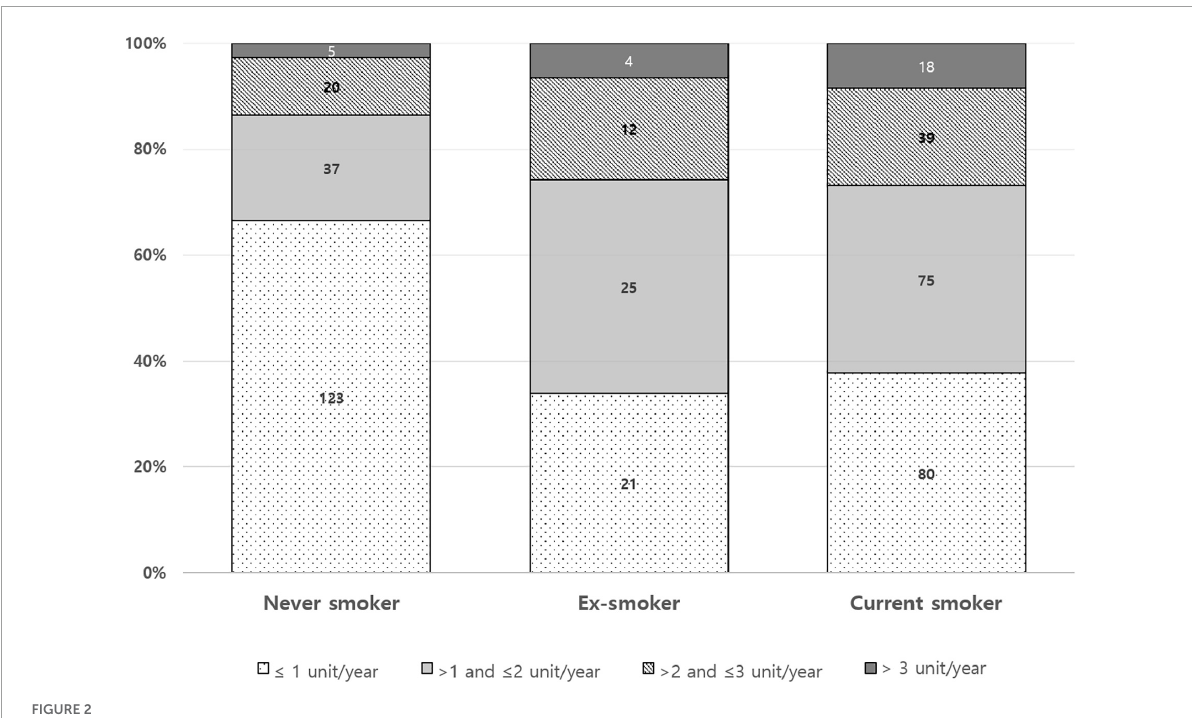
FIGURE2 Difference in mSASSS progression rate according to baseline smoking status.